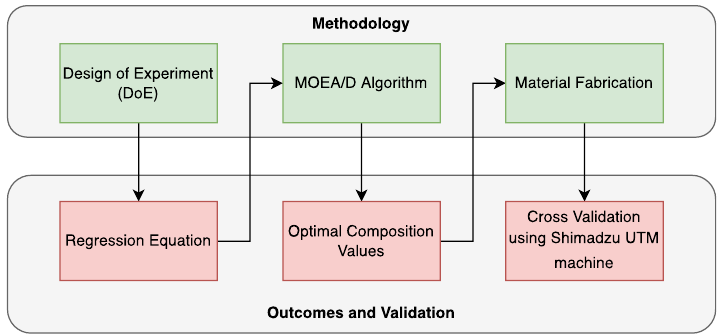
Figure 1. Process flowchart.